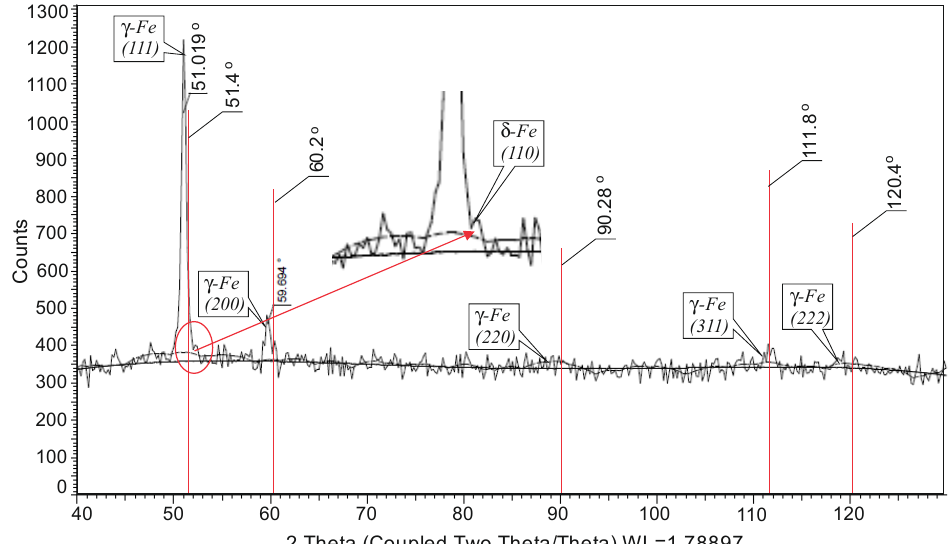
Figure 2. Phase analysis outcomes for AISI 304 steel.